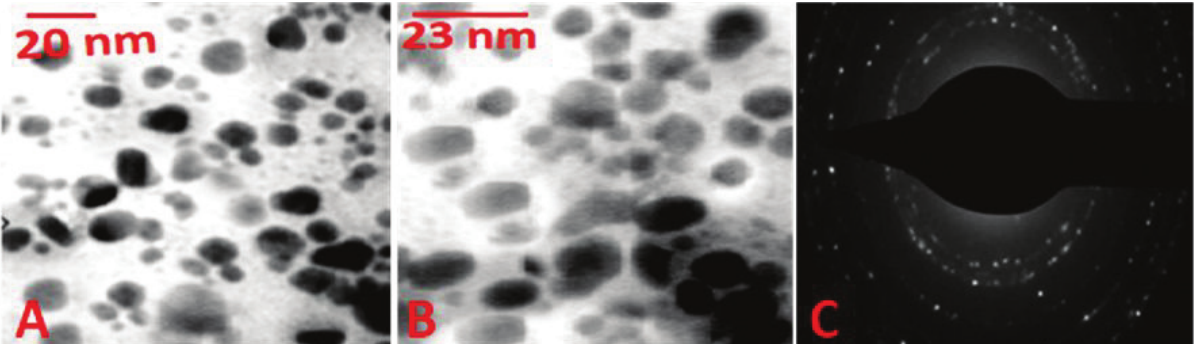
Figure 5: Transmission electron microscope images (a,b) of biosynthesized ZnO NPs and corresponding SAED pattern (c).